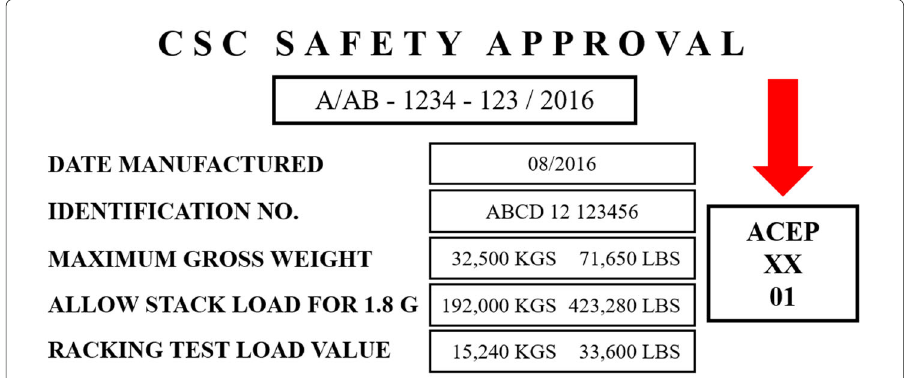
Fig. 5 ACEP-note on CSC plate (based on Strauch (2018),